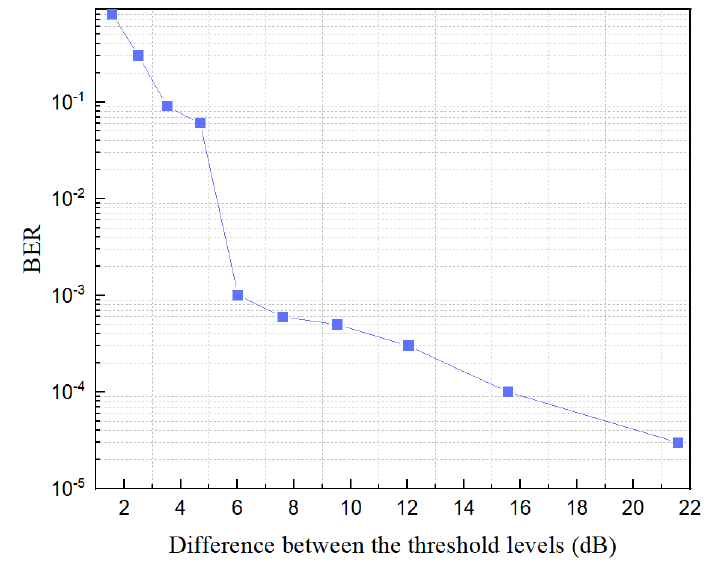
Figure 14. BER vs. difference between two threshold